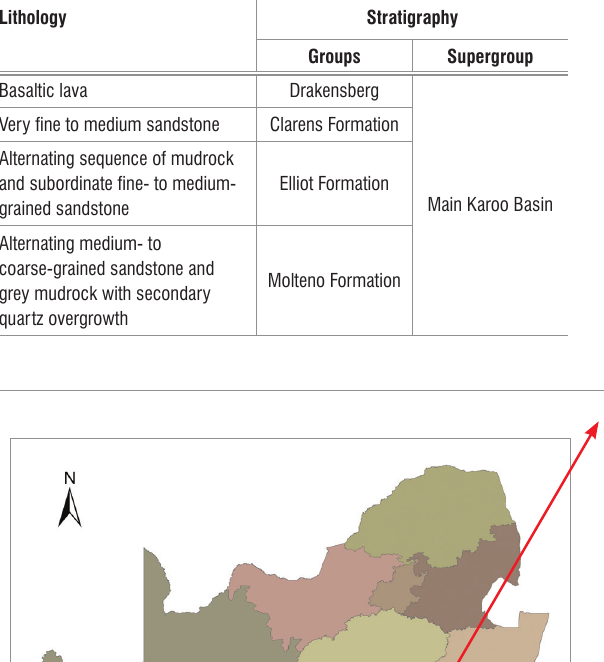
Lithology Basaltic lava